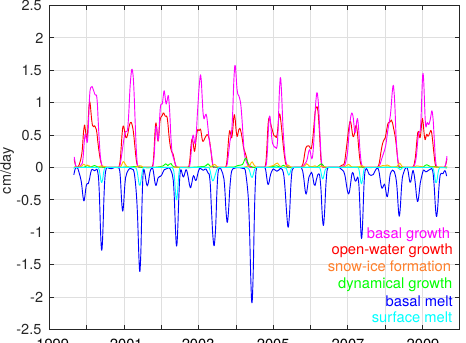
Figure 9. A 10-year inter-annual variability of the processes in- volved in ice evolution integrated over the Storfjorden area from the regional simulation. Processes are the same as in Fig. 6, plus an advection term corresponding to ice coming in and out of the area, which is not shown for more clarity. Units are in cmday − 1 . Positive and negative values represent creation and destruction of sea ice, re- spectively. Note that for more readability, variations are smoothed with a Hanning filter at a period of 2